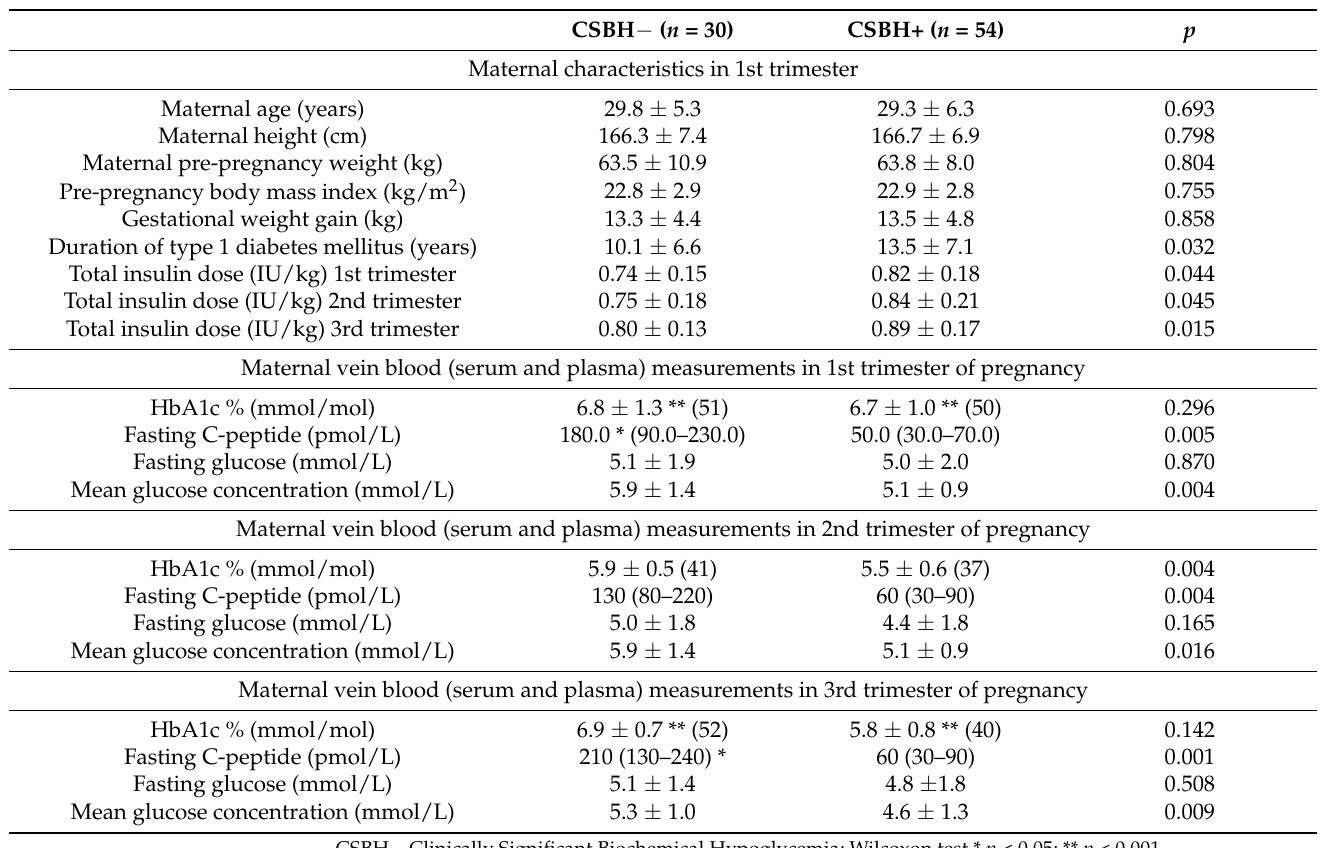
Table 1. Maternal characteristics according to groups and trimesters of pregnancy.